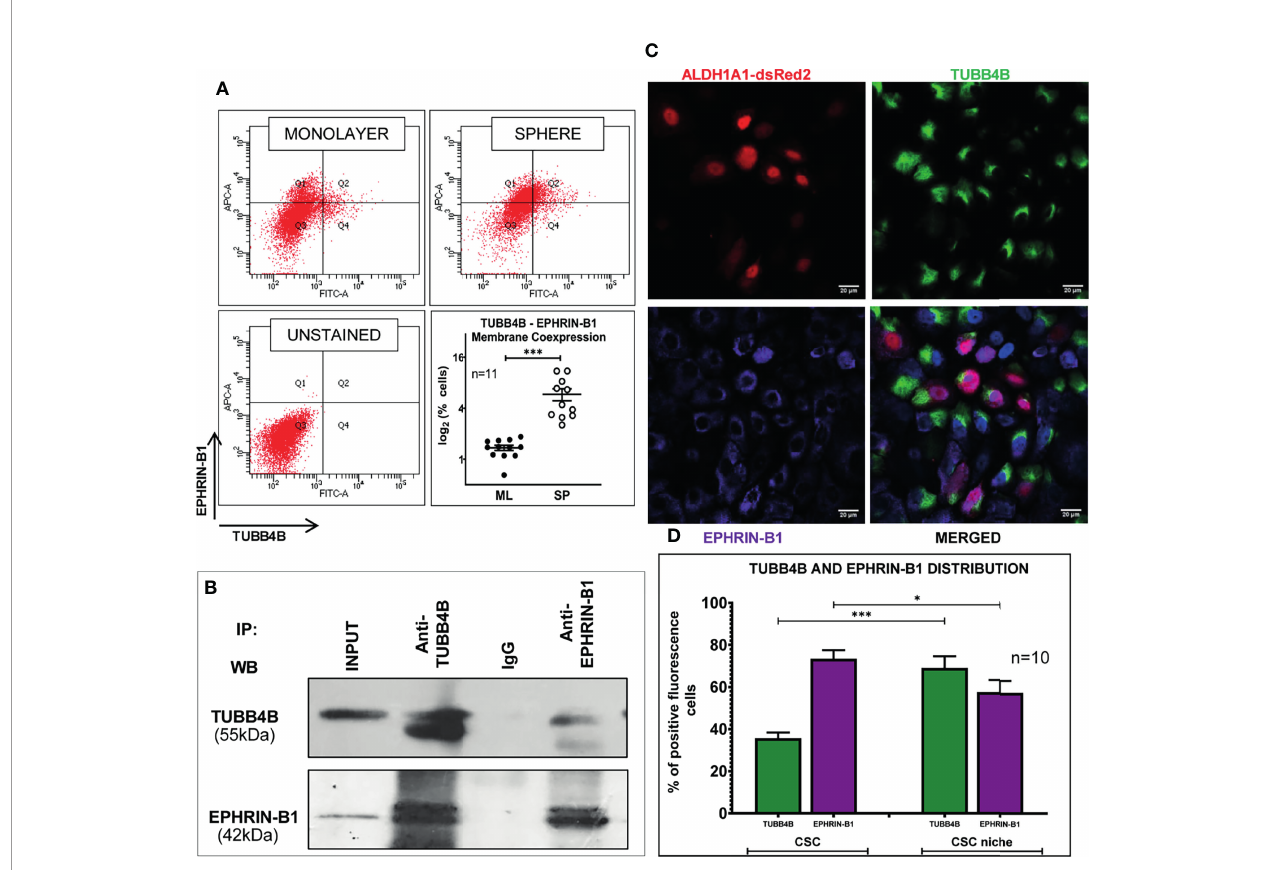
FIGURE 6 | TUBB4B and Ephrin-B1 physically interact in the CSC niche. (A) PFA fi xed monolayer (ML) and sphere (SP) cultures of HSC-3 cells were dual stained with fl uorophore tagged TUBB4B and Ephrin-B1 antibodies and the percentage dual positive cells were plotted. (B) Lysates of HSC-3 cells were immunoprecipitated with TUBB4B antibody and a reverse IP was performed using Ephrin-B1 antibody. The elutes were separated by SDS PAGE, transferred and probed for the indicated proteins. Isotype control mouse IgG antibody was used as the negative control. (C) Unpermeabilized HSC-3 cells with ALDH1A1-DsRed2 reporter were probed with TUBB4B and Ephrin-B1 antibodies, and confocal images were acquired. Cells with high fl uorescence intensities were manually counted for each channel in ALDH1A1 + cell clusters (the CSC population), and in the cells immediately surrounding the ALDH1A1 + cell, within a distance of 100 m m (considered to be the CSC niche cells). Of the total number of CSCs or the niche cells, the percentages of cells with high expression of each protein were plotted (D) . Cells were counted from 10 frames. * represents p-value < 0.05 and *** represents p < 0.001. Scale bar represents 20 m